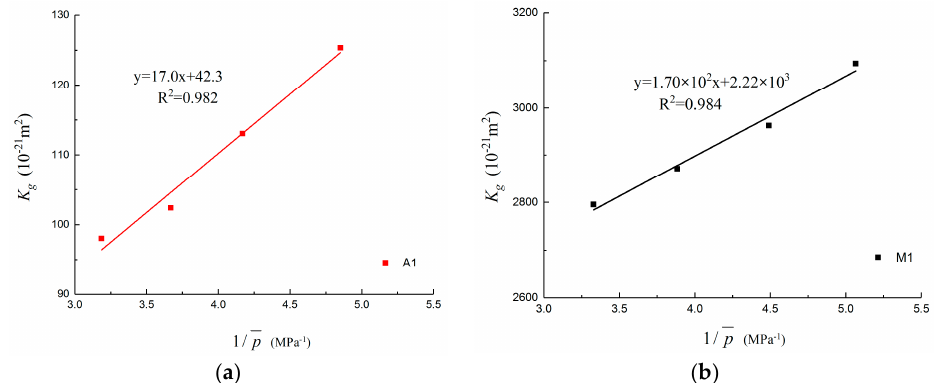
ral specimens. u